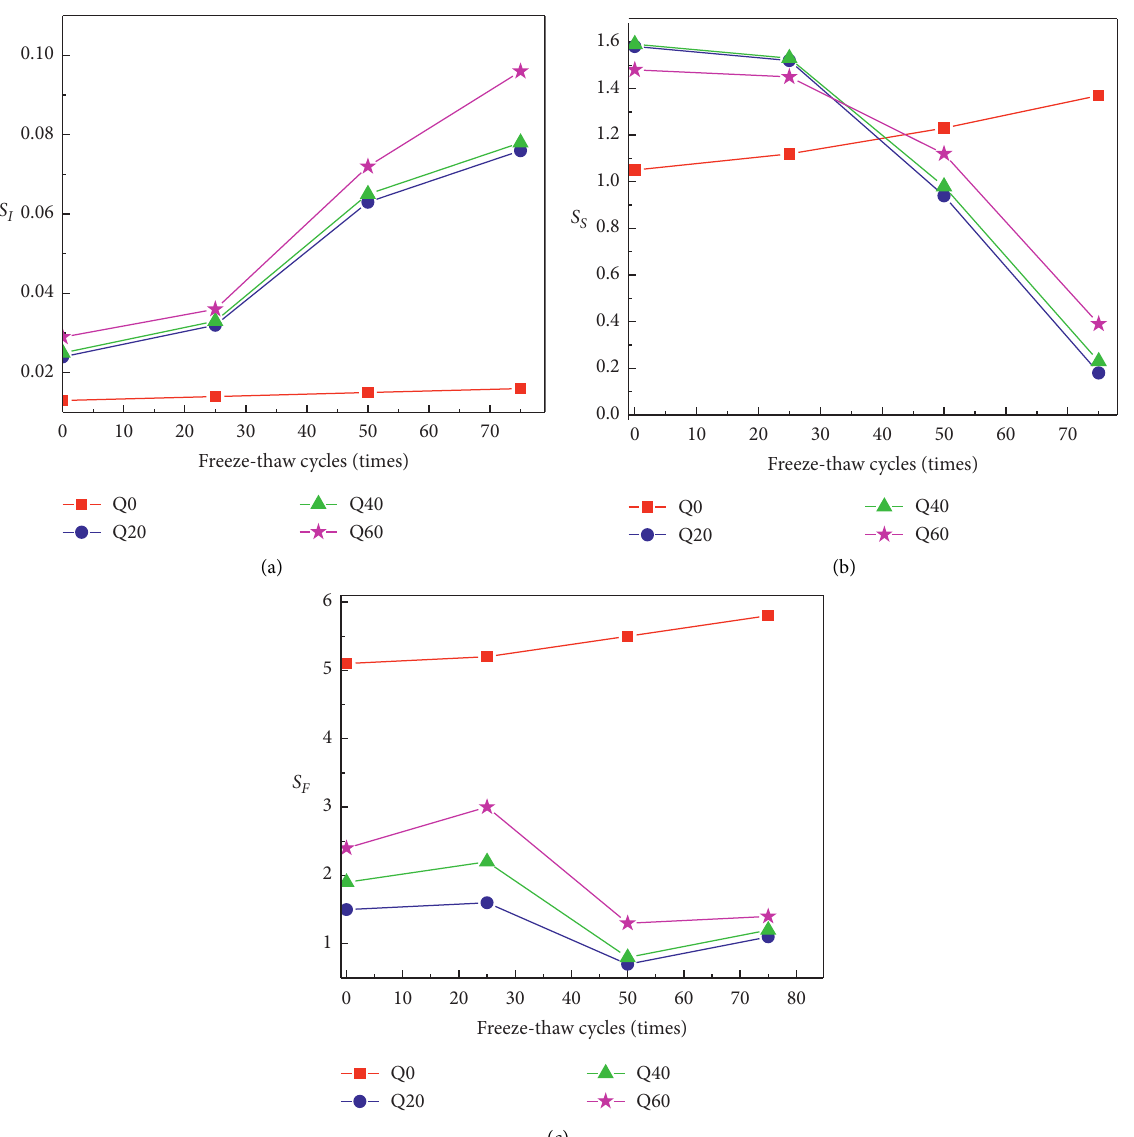
Figure 7: Change of capillary water absorption with freeze-thaw cycle. (a) Initial water absorption. (b) Secondary water absorption. (c) Late water